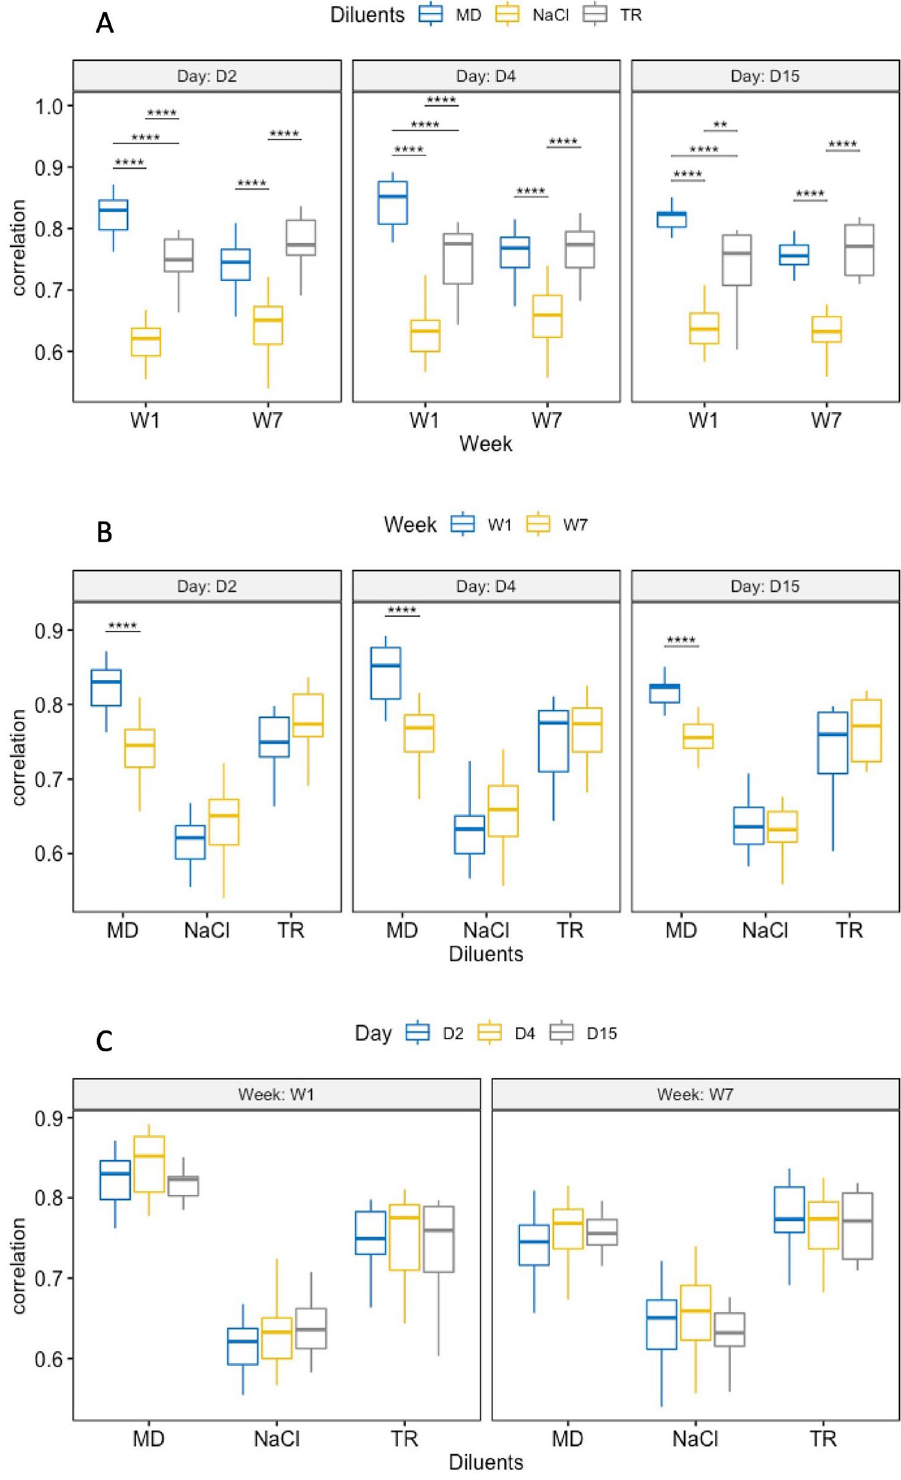
Figure 3. Pairwise comparisons between each cell of the design. ( A ) Effect of the diluent. ( B ) Effect of week of cryoconservation. ( C ) Day of